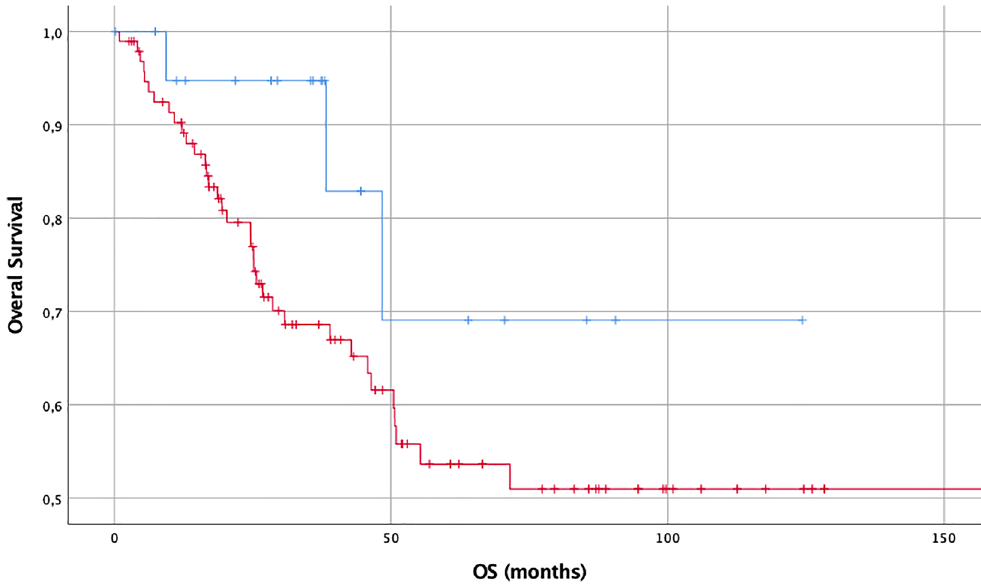
Figure 3. OS (months) in diffuse and anaplastic gliomas considering expression of GAP-43: no or slight expression (blue, n = 21) versus intermediate or strong expression (red, n = 96), demonstrating worse outcome for tumors, which are expressing more GAP-43.